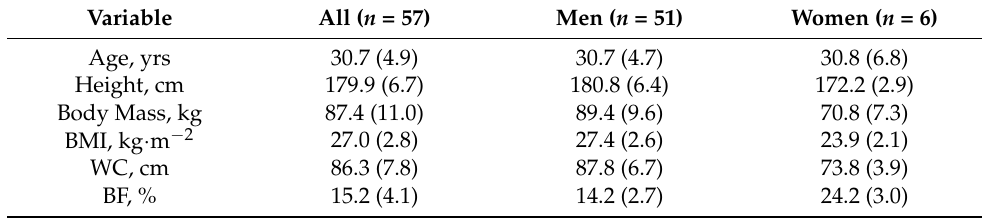
Table 1. Participant characteristics, mean